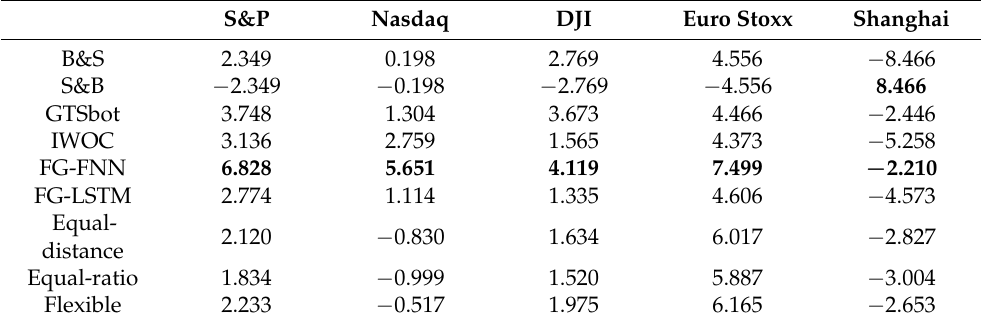
Table 19. Comparison of Sharpe